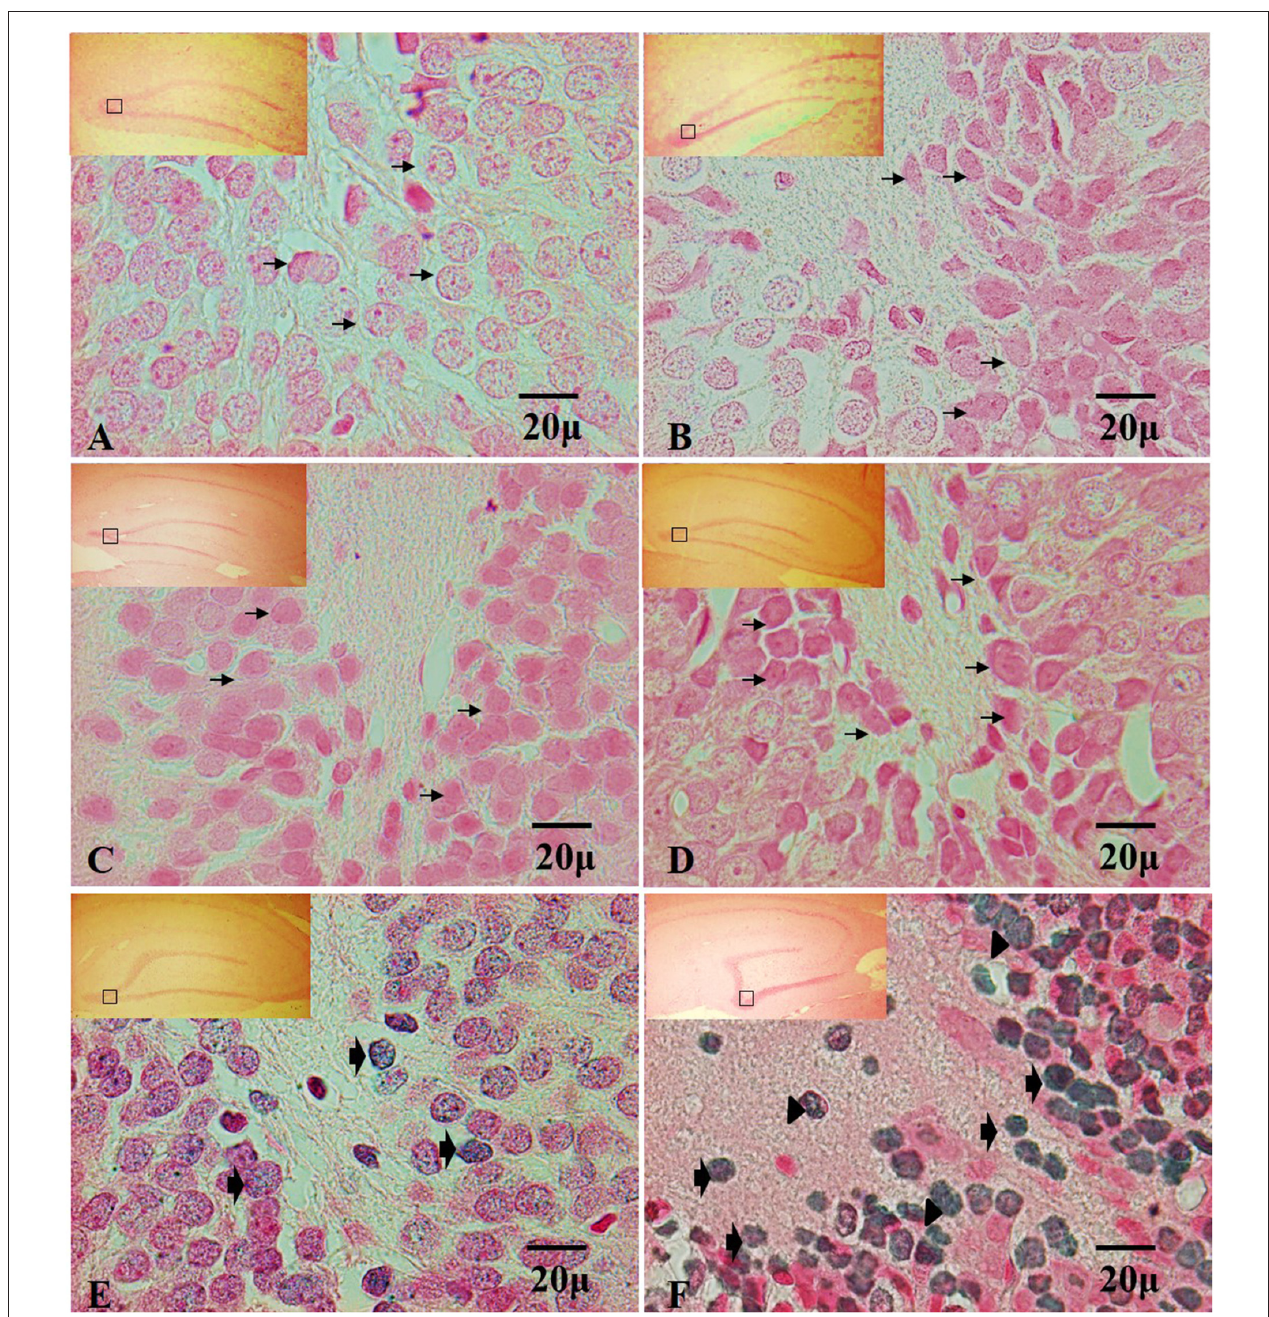
FIGURE 4 | Effect of chronic exposure to ozone on terminal deoxynucleotidyl transferase dUTP nick end labeling (TUNEL) positive cells in rat hippocampus. Micrographs of dentate gyrus of hippocampus of rats exposed to ozone. (A) Control, (B) 7 days (D), (C) 15D, (D) 30D, (E) 60D and (F) 90D. Micrographs (A–D) show non-positive cells for TUNEL (arrows show healthy cells). Micrographs (E,F) show an increase in TUNEL-labeled cells which displayed densely labeled, with different types of chromatin condensation. We observe chromatin grouped around the margin of the nucleus (broad arrow), chromatin condensation located in the center of the nucleus (arrowhead) and several after 60 and 90 days of exposure to ozone 100 × . The square indicates the area that is shown as 100 × magnification.